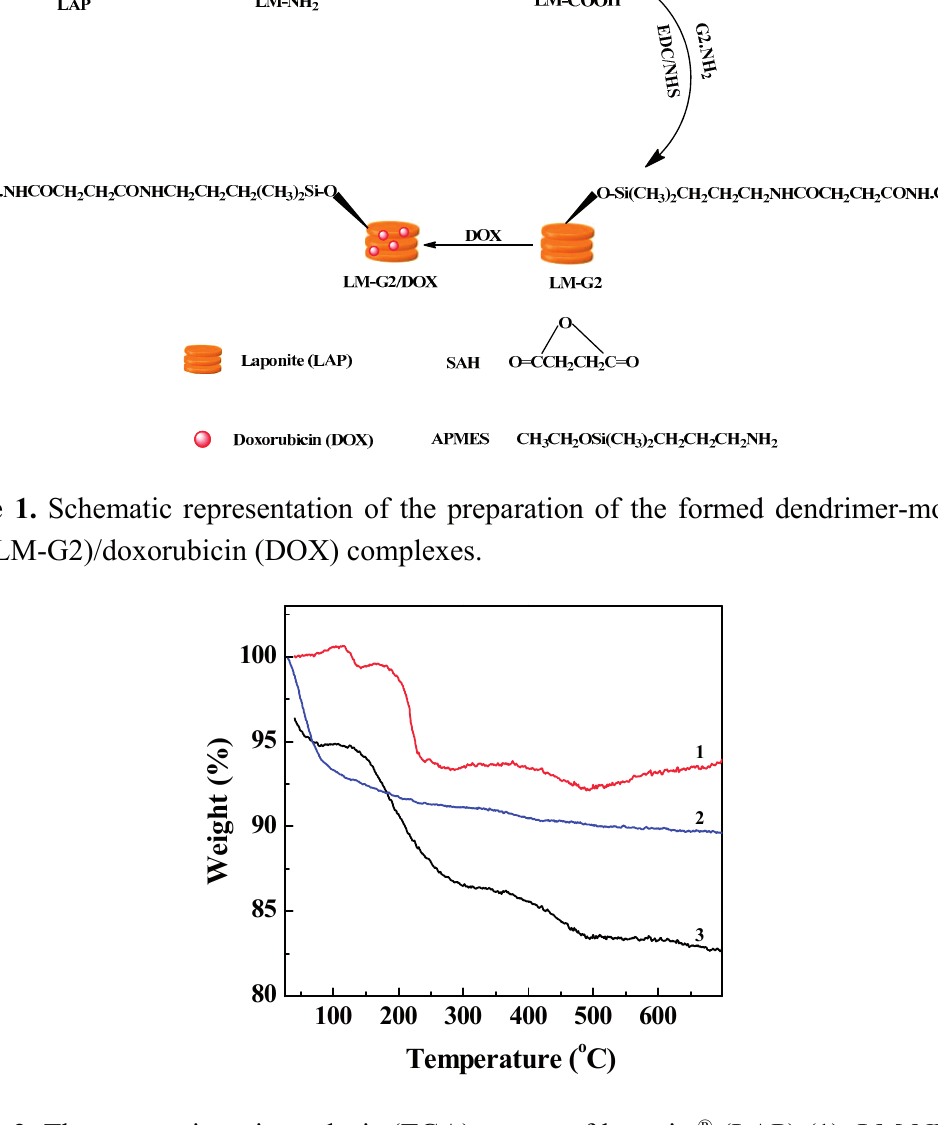
Figure 2. Thermogravimetric analysis (TGA) curves of laponite ® (LAP) (1), LM-NH 2 (2), and LM-G2